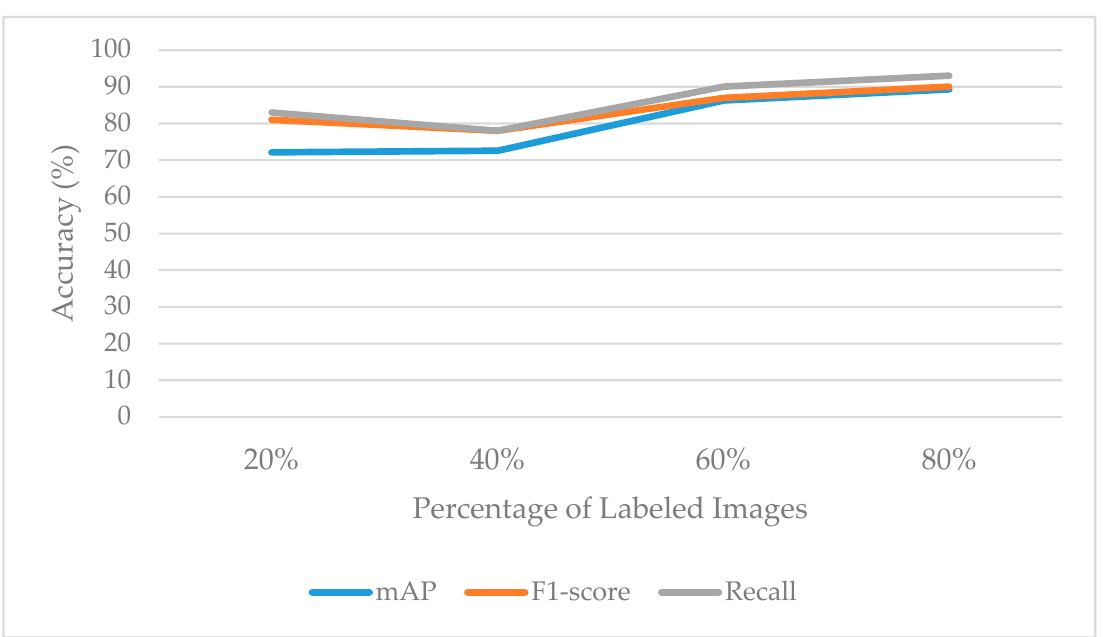
Figure 12. Success rates when different ratios of labeled data are considered. The sample object detection results related to the breakfast section are shown in Figure 13. Each subfigure shows the results obtained by the models that were trained using labeled samples varying from 20% to 80%. While some almost-empty areas, which are highlighted in red color, could not be detected with a 20–80% labeled-unlabeled ratio, these areas could be detected with higher labeled data ratios. The detection accuracy of almost-empty areas was increased as the labeled data ratio was increased. Besides, from the SOSA XAI perspective, the results were interpreted in a more understandable way for users. SOSA XAI output message is as follows: “8 almost-empty and 4 empty shelves are existing on the breakfast section. In order to determine the section, the products on the picture are counted and the category that has the most products is